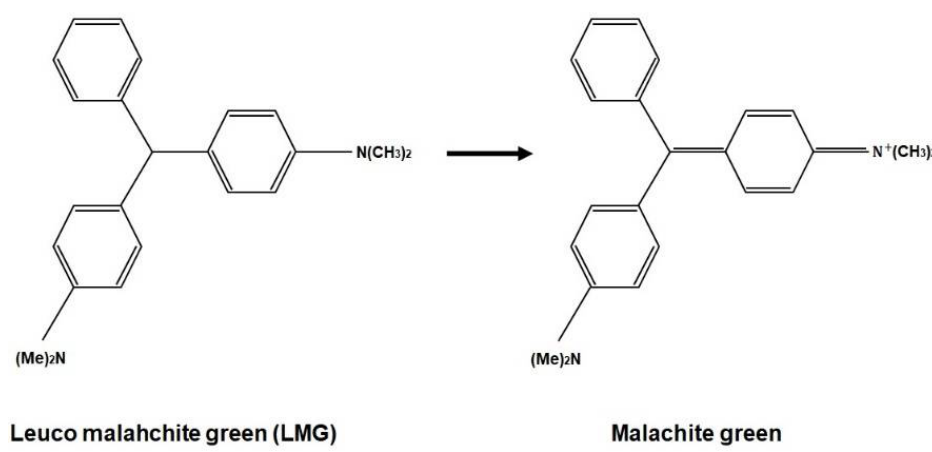
Figure 3. The chemical formula of radiochromic response.